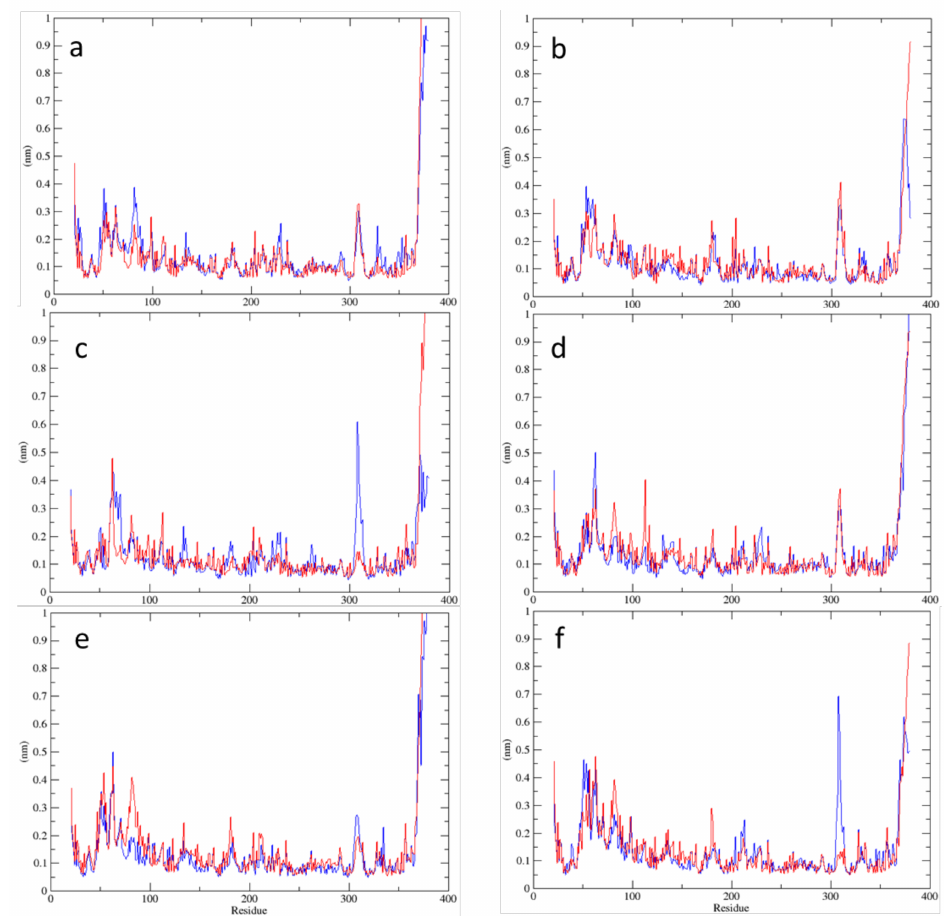
Figure 4. Representative results of RMSF analysis for simulations with arginine in the active site. ( a ) wtGALT + arginine; ( b ) p.Gln188Arg + arginine; ( c ) wtGALT + G1P + arginine; ( d ) p.Gln188Arg + G1P + arginine; ( e ) wtGALT + H2U + arginine; ( f ) p.Gln188Arg + H2U + arginine. Blue lines represent RMSF fluctuation of chain A; red lines, that of chain